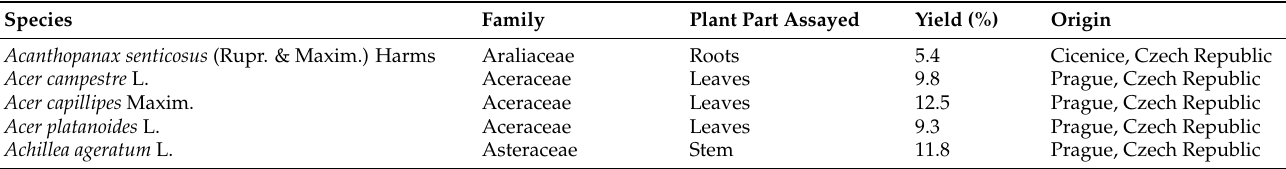
Table 1. Plants used in this study, their part used, origin, and yield of